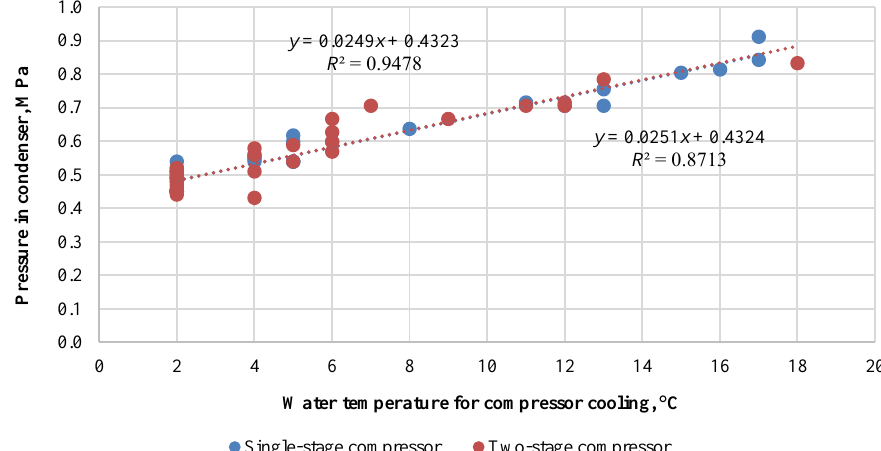
Fig. 10. Single-stage and two-stage compressor condenser pressure depending on cooling water